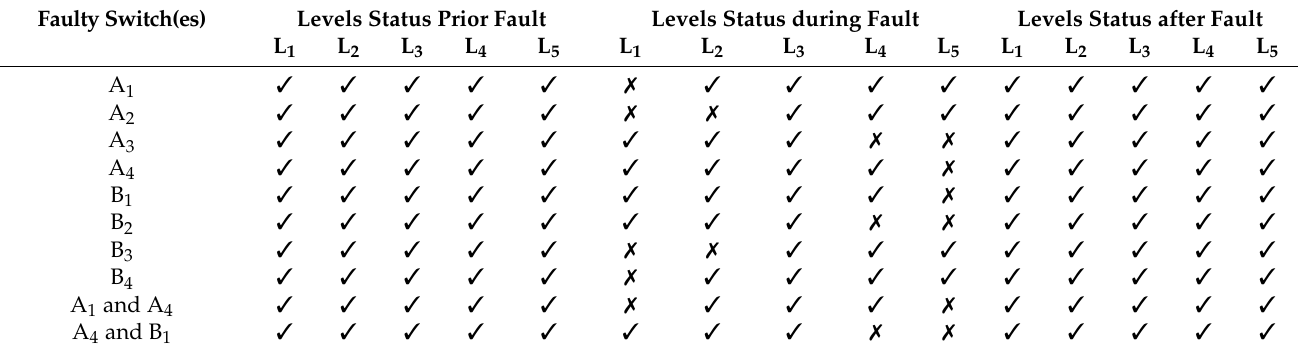
Table 9. Output voltage level status under healthy, faulty, and post-fault conditions.